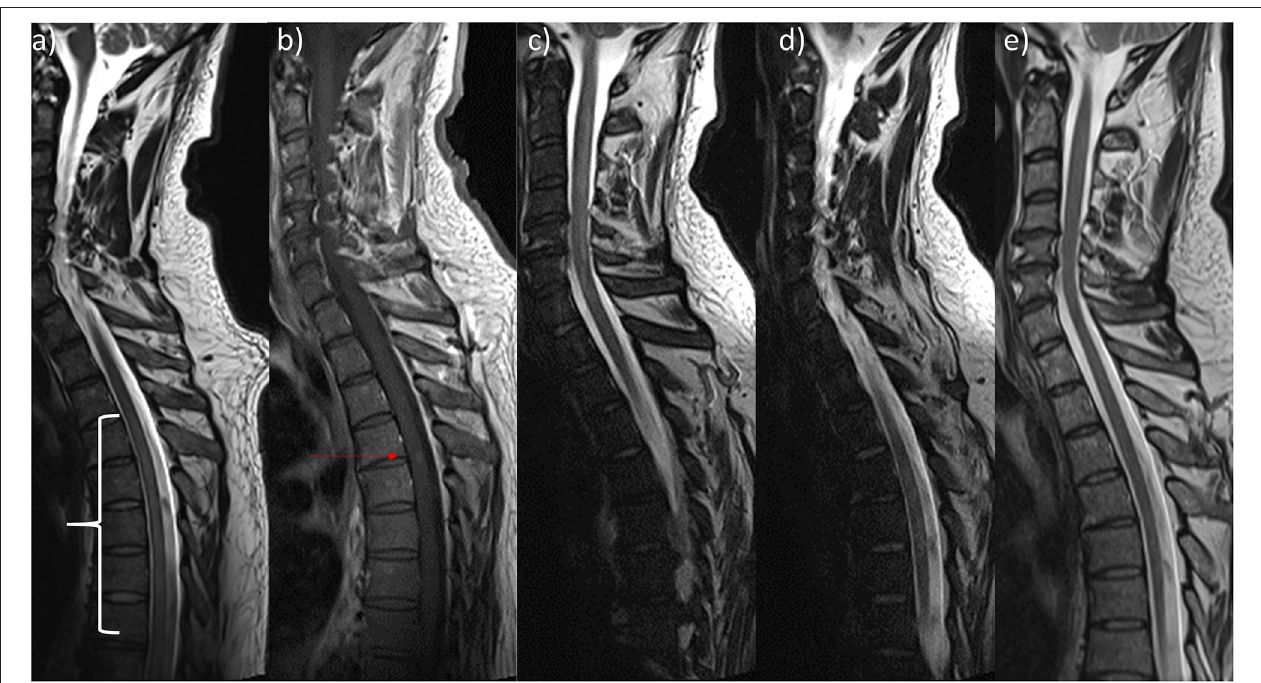
FIGURE 1 | Sagittal Magnetic resonance imaging of patient’s spine. (a) On admission there was discrete signal enhancement spanning from T4 to T11 in T2-weighted sequences. (b) 2 weeks later, there was a discrete contrast enhanced signal at the height of T4/5 in T1-weighted sequences. (c,d) Prior to discharge, T2-weighted sequences showed (c) a new cervical lesion spanning from C3 to C7 and the unchanged signal enhanced thoracic lesion (d) . (e) Resolvance of myelopathic changes 1 year after initial